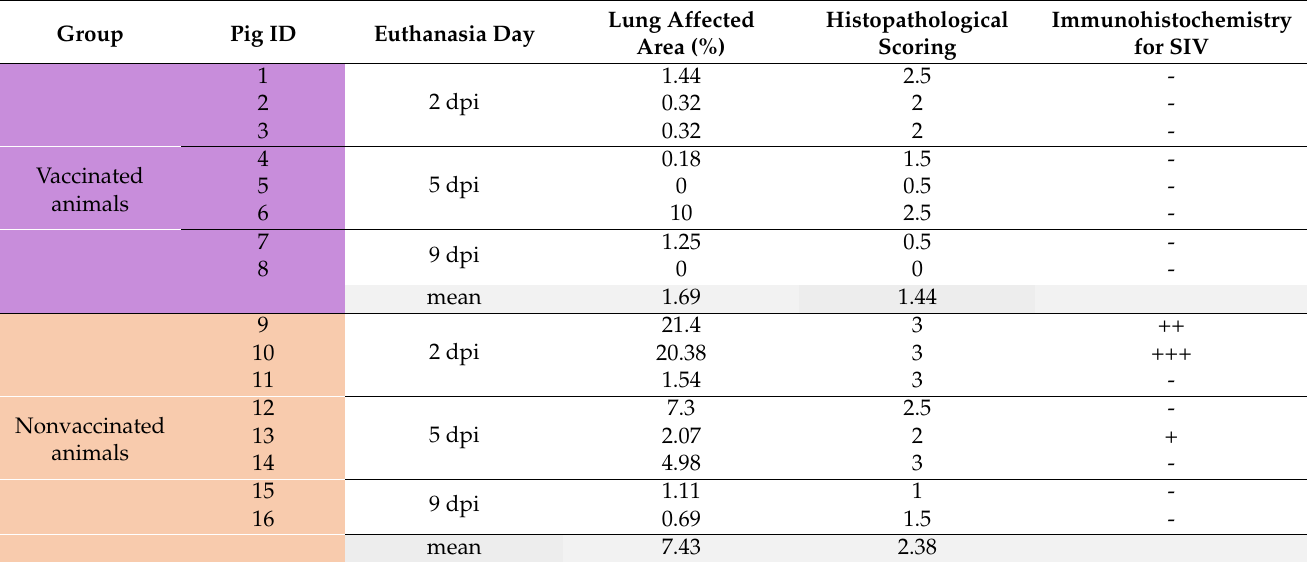
Table 3. Pathological results based on gross (percentage of lung-affected area) and histopathological observations, including the semi-quantitative scorings for HE and IHC in lung samples.